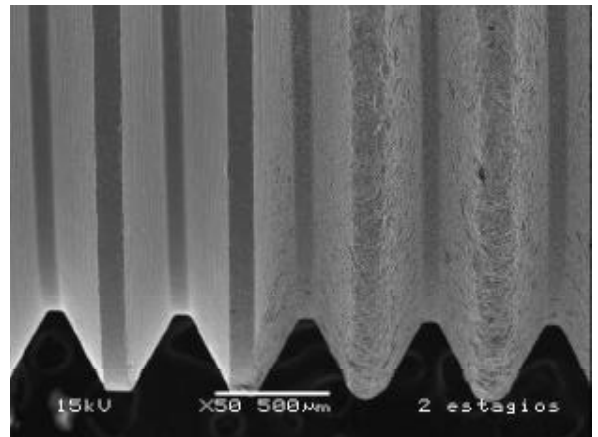
FIGURA 1- Aspecto macroscópico dos implantes e dos intermediários nos sistemas de dois (A) e um (B) estágios